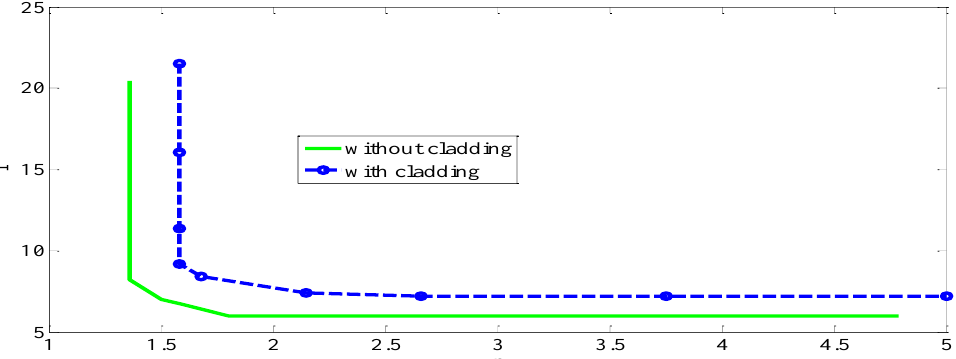
Fig. 18. Non-dimensional parameter pi diagrams of the structures without and with cladding material for Blast load acting on rear wall (19) .